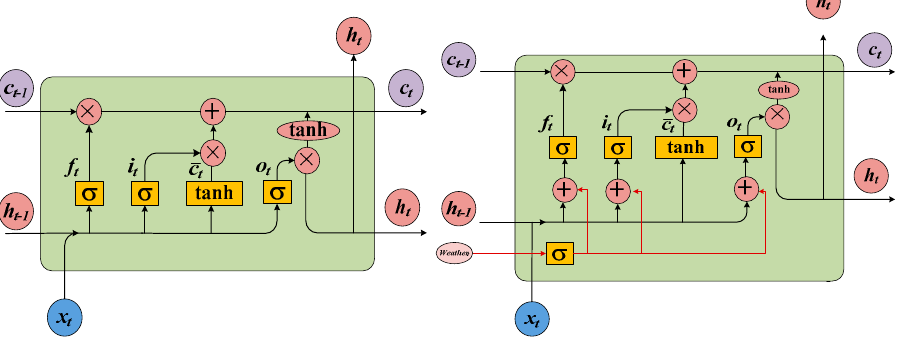
Figure 8. Internal structure of LSTM model and LSTM model with weather influence feature.